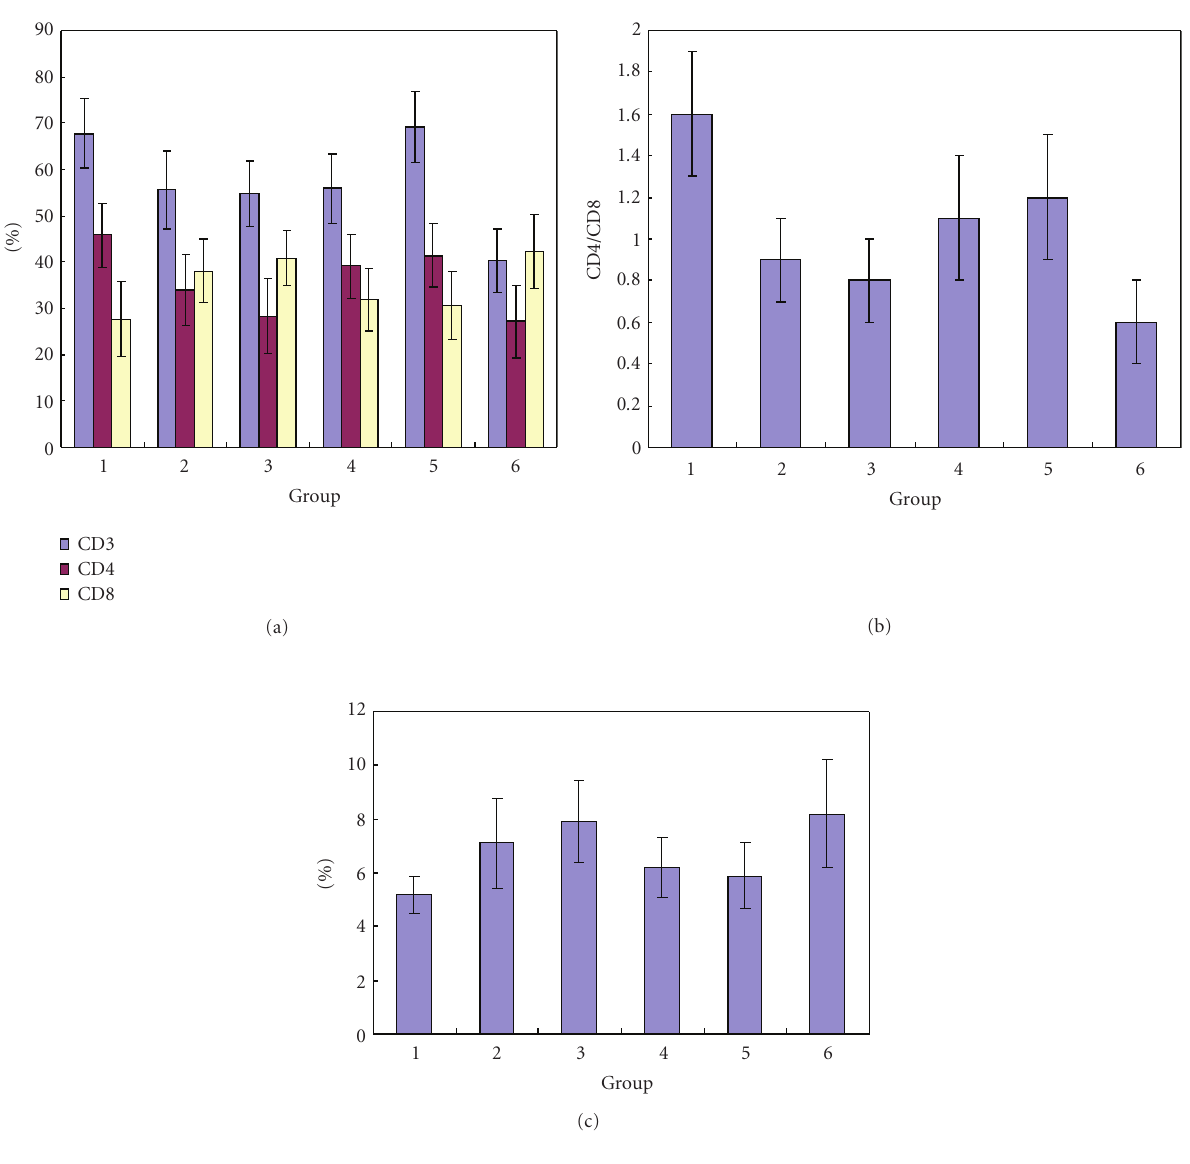
Figure 5: T cell immunity of di ff erent groups. (a) CD3, CD4, and CD8 cells in di ff erent groups, (b) CD3/CD8 in di ff erent groups, (c): CD4 + -CD25 + -Foxp3 + -Treg cells in di ff erent groups, 1: healthy controls, 2: GCA patients, 3: GCA patients with TSP1 methylation, 4: GCA patients without TSP1 methylation, 5: stage I and II GCA patients, 6: stage III and IV GCA